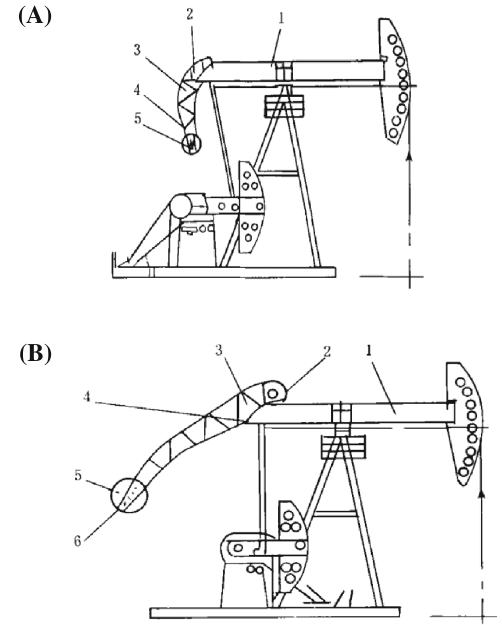
Fig. 5 Compound balanced pumping units with lower balance weight (Liu 2013). a Interpolating style, 1 beam pump units, 2 balance weight of pumping units, 3 lower partial part, 4 lower balance weight, 5 adjust hole. b Upwards style, 1 beam pump units, 2 support, 3 lower partial part, 4 adjust block, 5 lower balance weight, 6 adjust hole